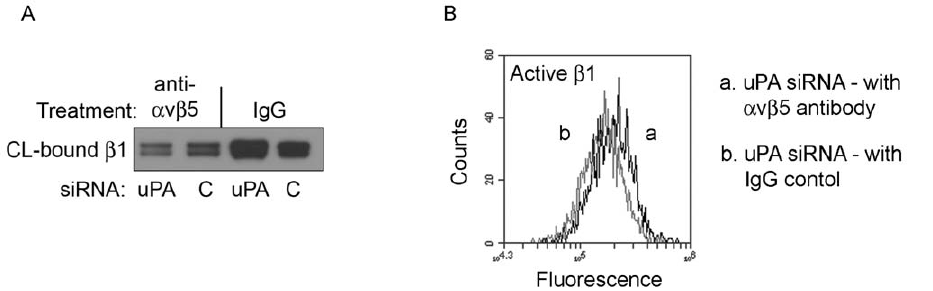
Figure 7. b 1 integrin is activated by blocking integrin b 5. (A) HCFs were transfected with uPA siRNA or control siRNA and seeded with a blocking a v b 5 antibody or matched IgG. After 24 hours HCF were crosslinked to collagen. The amount of b 1 released from the matrix after cell removal is visualized by Western blot. (B) HCFs were transfected with uPA siRNA. After 24 hours, cells were analyzed by flow cytometry for activated integrin b 1. N=3 for each experiment.